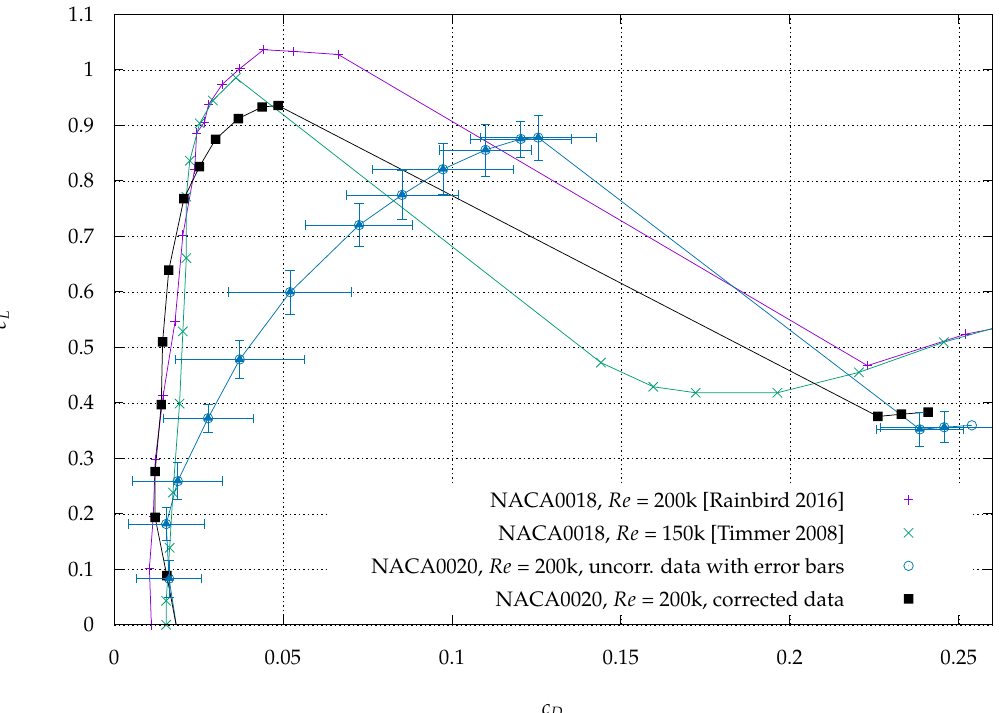
Figure 6. Comparison of corrected and uncorrected polars from our study with two similar flapless profiles from the literature; the uncorrected polar includes error bars with standard